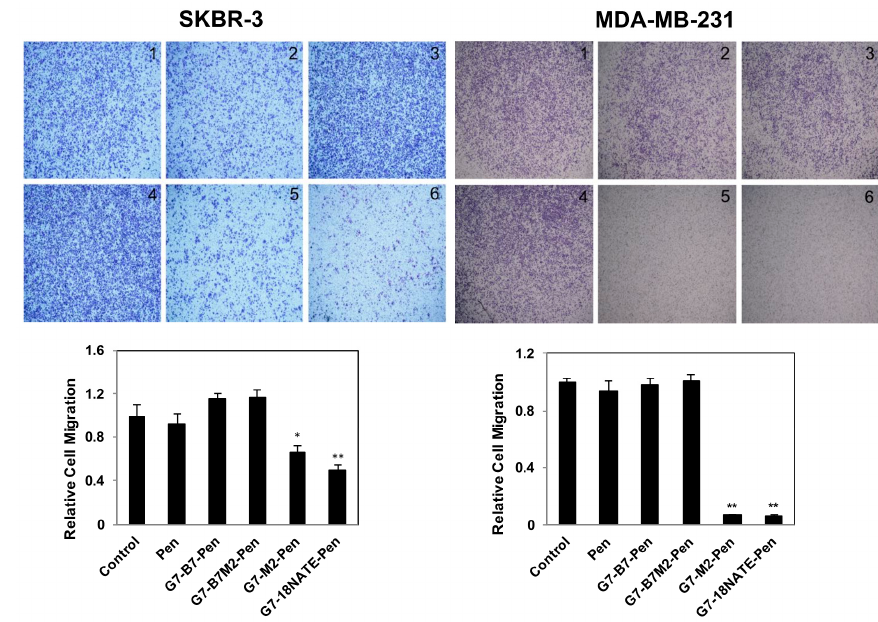
Figure 5. E ff ect of the G7-peptide inhibitors on MDA-MB-231 and SKBR-3 cell migration using a Transwell assay. SKBR-3 and MDA-MB-231 cell lines were treated with 20 µ M of the control peptide (Pen) or 20 µ M G7-peptide inhibitors for 30 h (SKBR-3) or 4 h (MDA-MB-231) at 37 ◦ C. Cell motility was measured using the Transwell assay. Top: Representative images of migrated SKBR-3 and MDA-MB-231 cells (image 1, Control; 2, Pen; 3, G7-B7-Pen; 4, G7-B7M2-Pen; 5, G7-M2-Pen; 6, G7-18NATE-Pen). Bottom: Migrated cells are expressed relative to the untreated control MDA-MB-231 and SKBR-3 cells, which is normalized to 1.0. Bars represent mean ± SEM for at least three independent experiments with duplicates. A student (cid:48) s t-test was performed between control (non-treated) and G7-peptide treated samples with * p < 0.05, ** p <